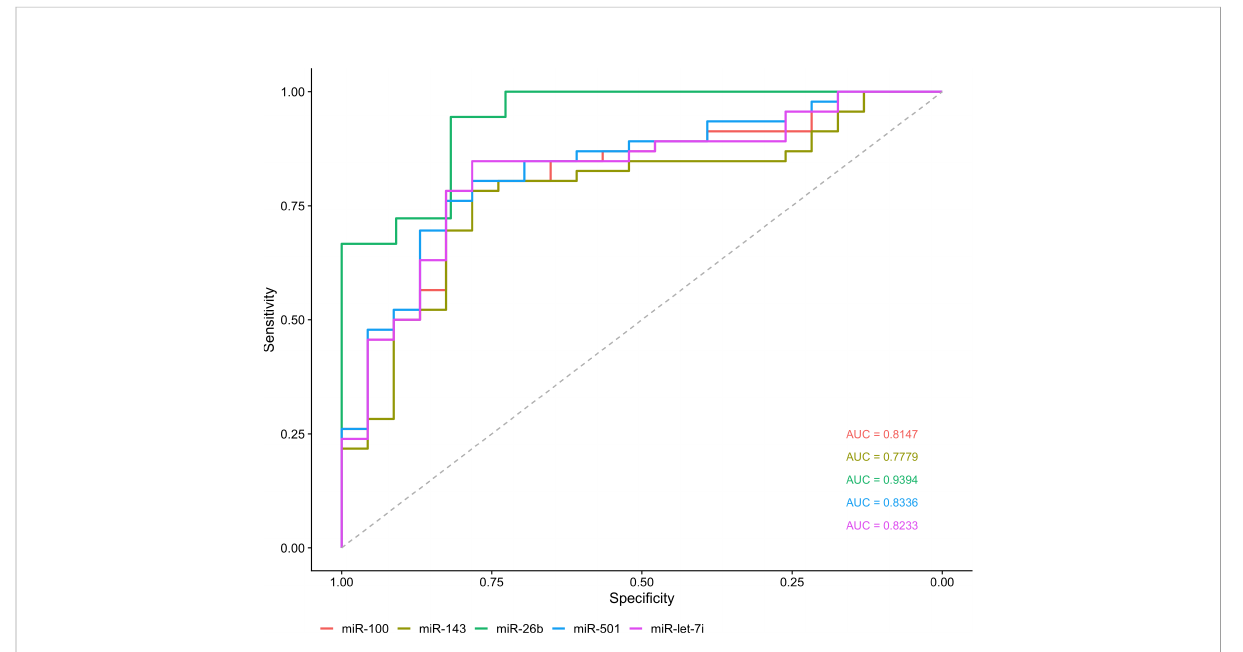
FIGURE 6 Analysis of biomarker sensitivity of fi ve validated miRNAs in T1DM.